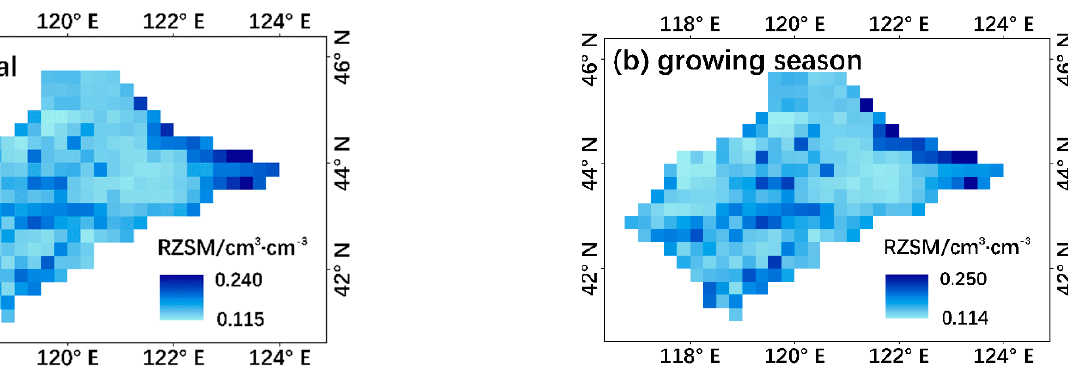
Figure 6. RMSE (cm 3 ·cm − 3 ) and correlation R between the root-zone soil moisture estimates by the regional SMAR and the in-situ root-zone soil moisture measurements at each pixel where in situ sites were located. The dashed line represents NASA’s quality benchmark (0.06 cm 3 ·cm − 3 ) for soil moisture predictions using satellite observations.